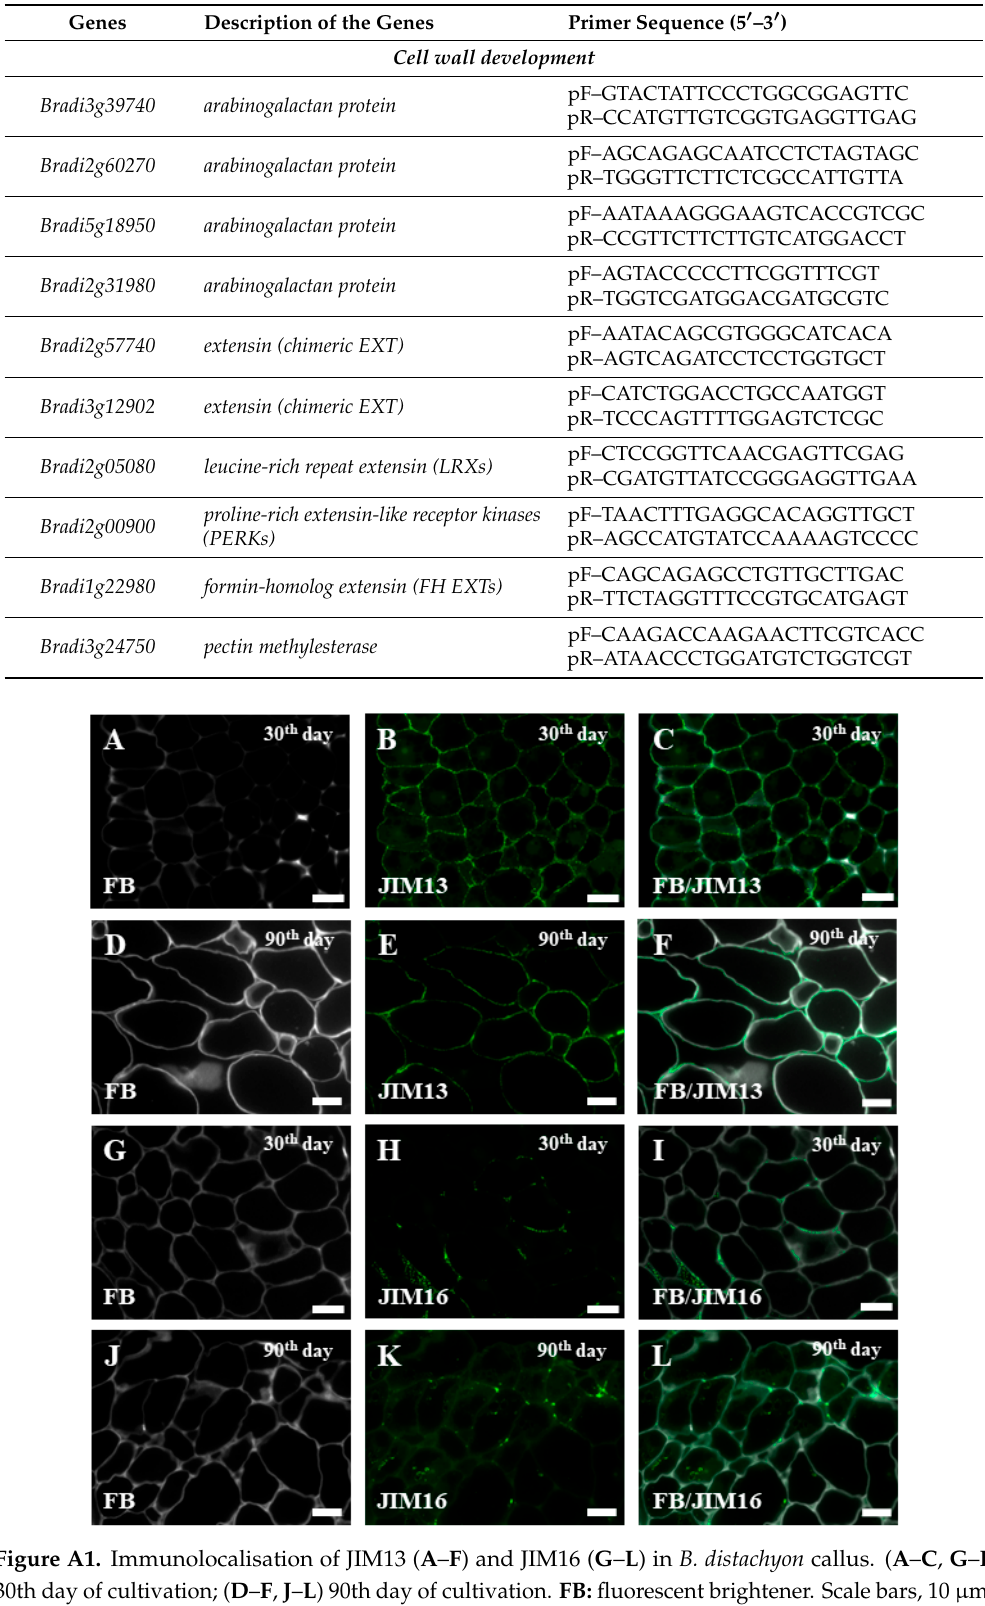
Figure S2. Immunolocalisation of LM2 ( A – F ) in B. distachyon callus. ( A – C ) 30th day of cultivation; ( D – F ) 90th day of cultivation. Scale bars, 10 μ m.